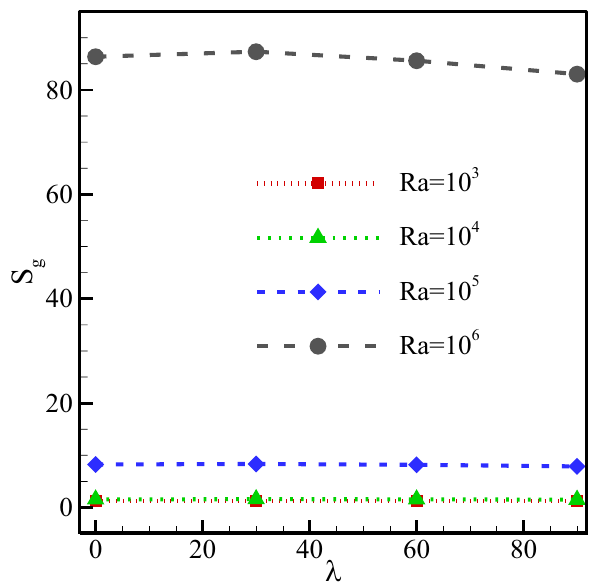
Figure 13. Total generated entropy for different Ra at φ = 0.3, γ = 45°, Ha = 20, Rad =